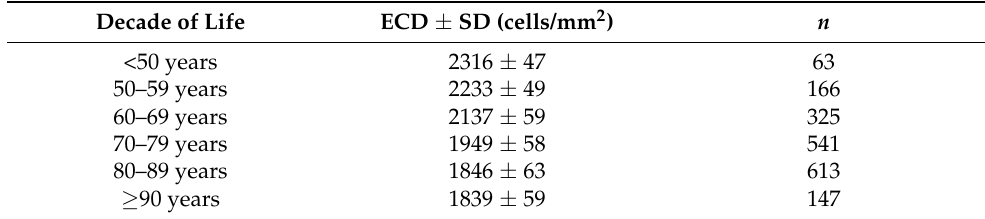
Table 7. Association analysis of ECD with ocular and donor characteristics. Linear regression anal- ysis using a mixed model.